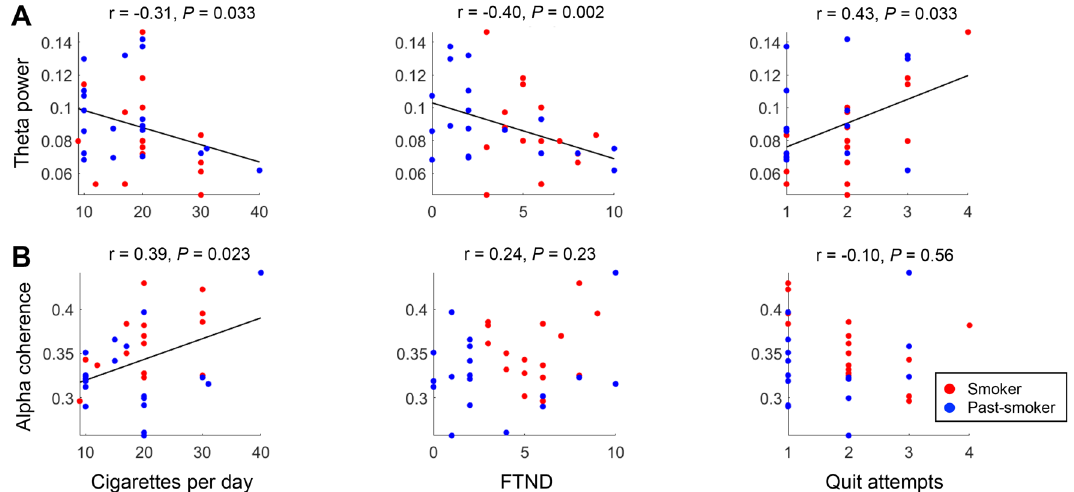
Figure 4. Correlations between EEG features and individuals’ smoking-related characteristics. Pearson’s correlation coefficients were calculated to examine the association between EEG characteristics (relative EEG band powers and coherence) and individuals’ smoking history measures (cigarettes per day, FTND, and number of quit attempts). ( A ) Across smokers and past-smokers, individuals who have smoked more (or had smoked more in the past for past-smokers) showed lower theta band power, ( B ) but higher alpha coherence. ( A ) In addition, individuals who self-reported higher nicotine dependence (FTND score) showed lower theta band power, and who had more quit attempts showed higher theta power. Each dot represents an individual participant, and the color-coded lines are the regression line between the corresponding